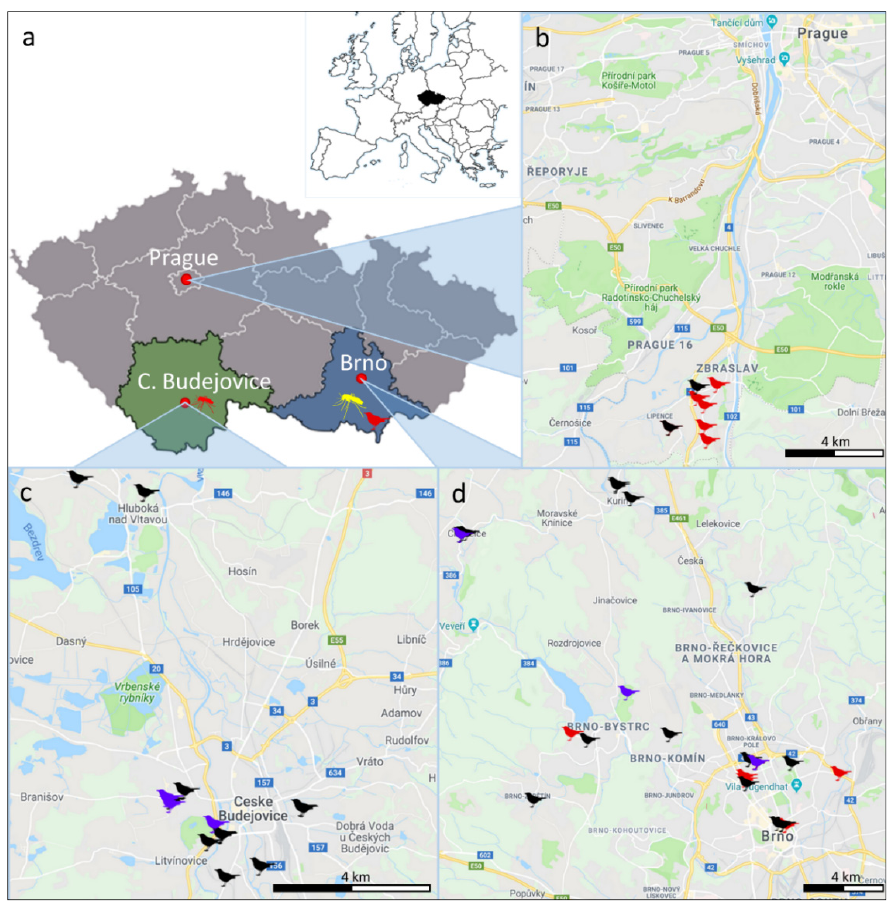
Table 1. Numbers of cadavers of blackbirds ( Turdus merula ) and song thrushes ( T. philomelos ) collected in the three geographical locations in the Czech Republic, 2017–2019.